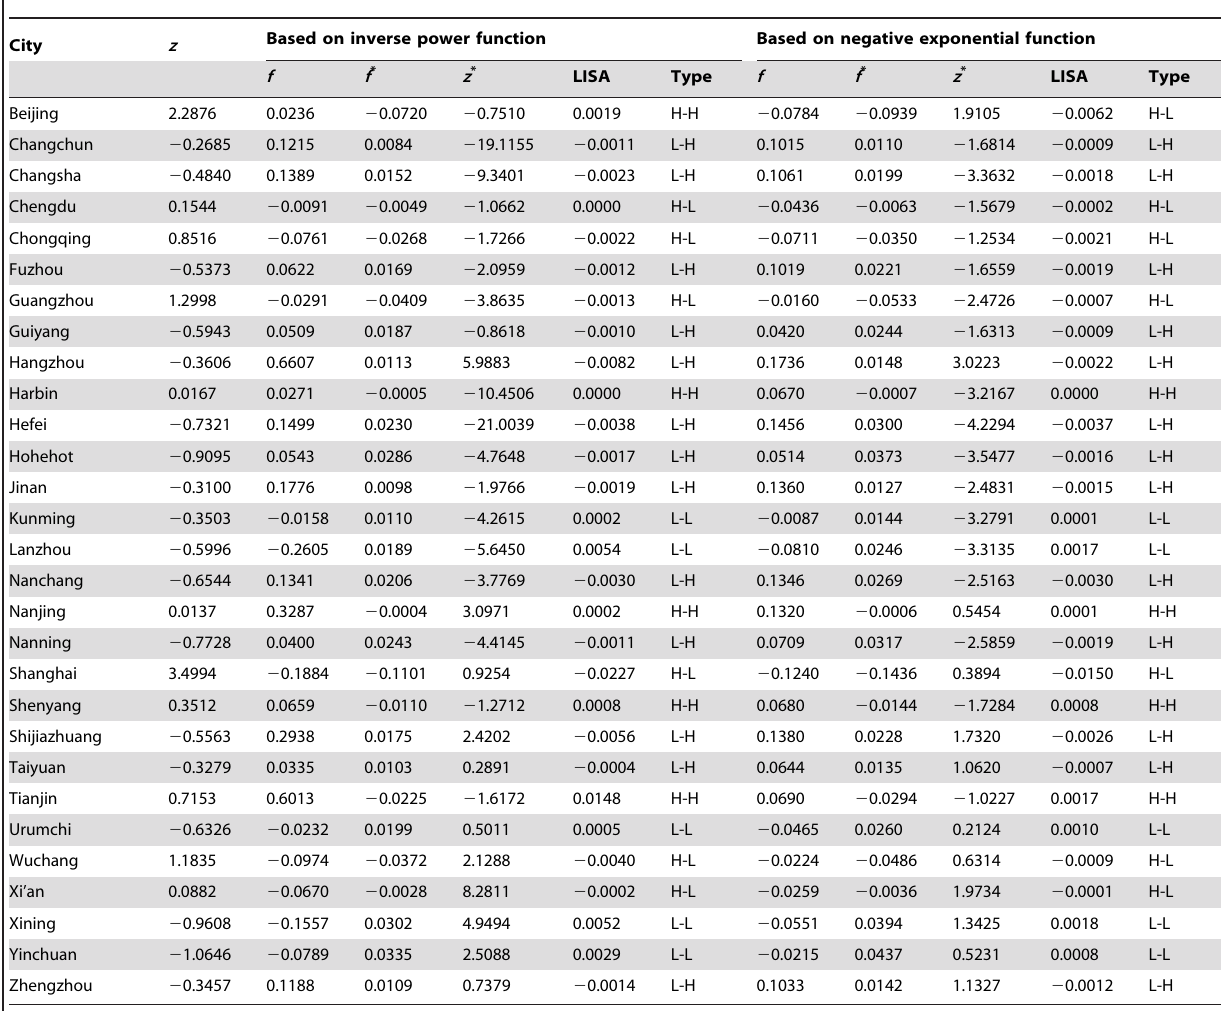
Table 3. Classification of spatial autocorrelation based on population size of the principal cities in China (2000).